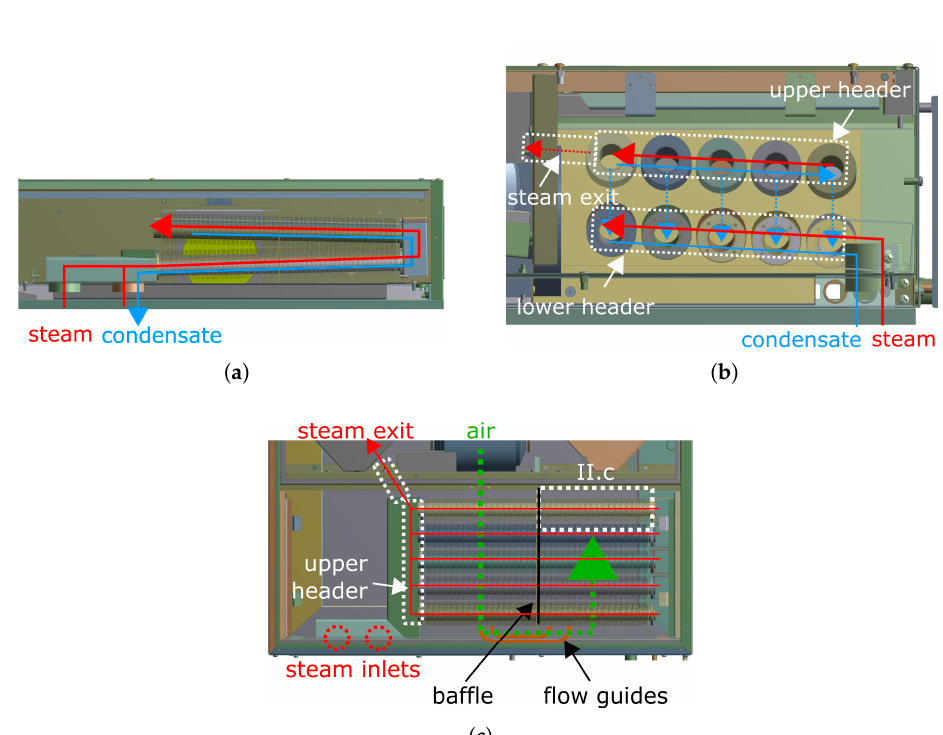
Figure 2. Redesigned heat exchanger: ( a )—rear view; ( b )—side view; ( c )—top view. II.c—air